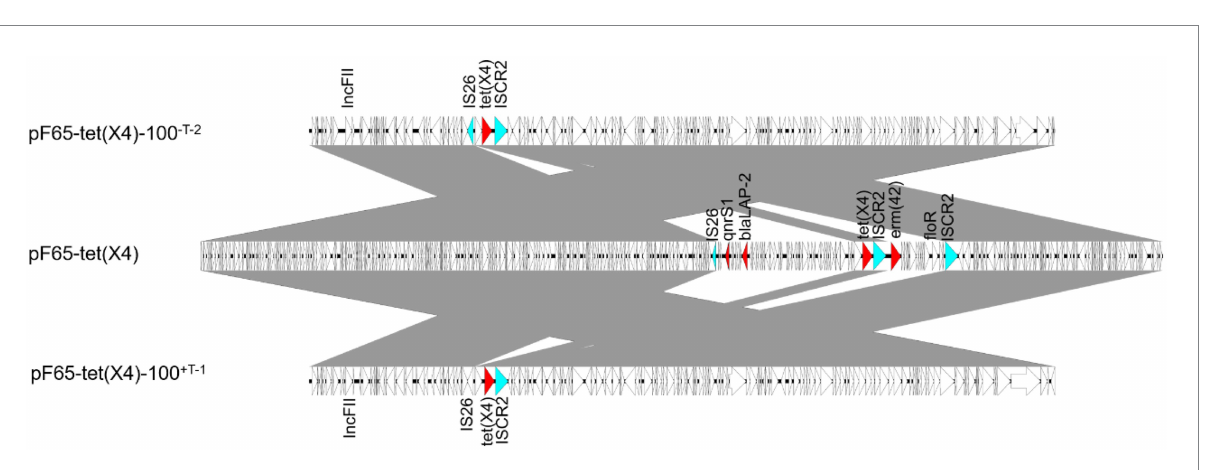
FIGURE 5 Linear comparison among pF65- tet (X4) and two evolved plasmids. Two segments were discarded during evolution, and the AMR genes and insertion sequences in deleted regions were marked in red and blue,